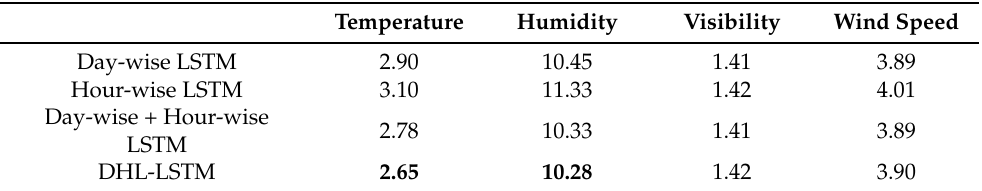
Table 4. Performances of different variants of the 2D-RNN models, i.e., the day-wise-only prediction model; the hour-wise-only prediction model; the day-wise plus hour-wise prediction model; and the one containing day-wise, hour-wise, and L-shaped predictions (denoted as DHL-LSTM).